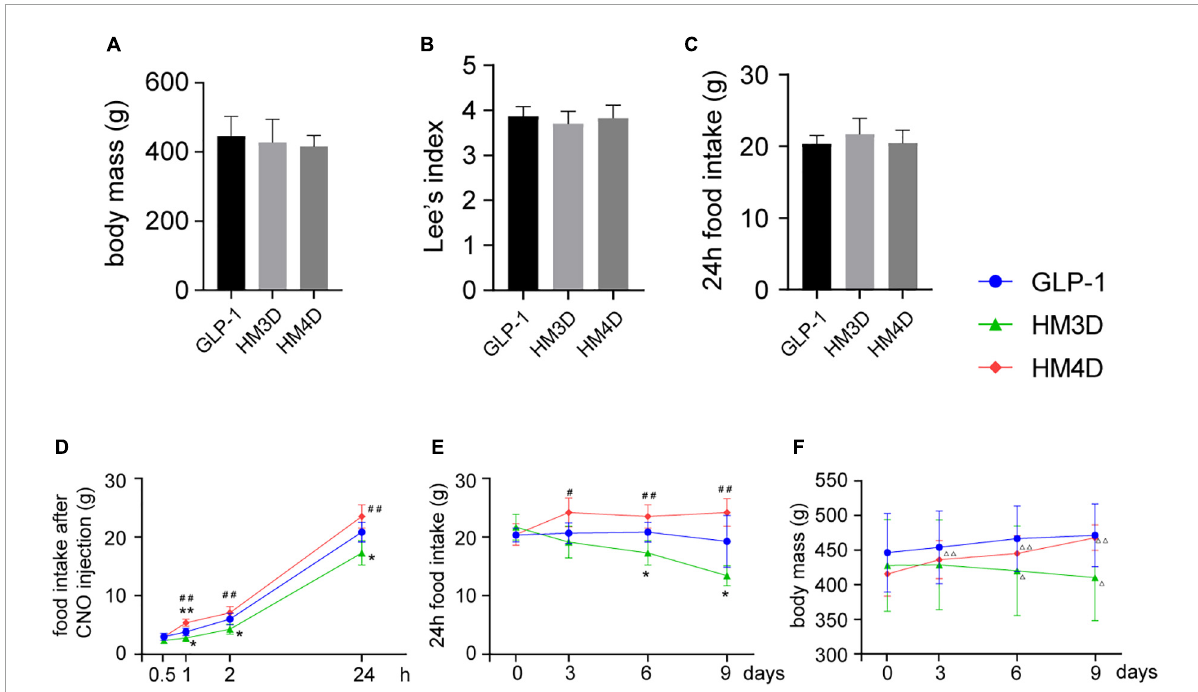
FIGURE5 Appetite-related behavioral changes in each group. (A–C) Baseline of body mass, lee’s index, and 24 h food intake of rats in each group, which were collected at day 0; (D) cumulative food intake of rats in each group at different time points after the first CNO injection; (E) changes in 24 h food intake of rats in each group after CNO injection during the intervention period; (F) changes in body mass of rats in each group during the intervention period; vs. GLP-1 group, * P < 0.05, ** P < 0.01; vs. HM3D group, # P < 0.05, ## P < 0.01; vs. day 0, (cid:77) P < 0.05, (cid:77) (cid:77) P < 0.01. CNO,